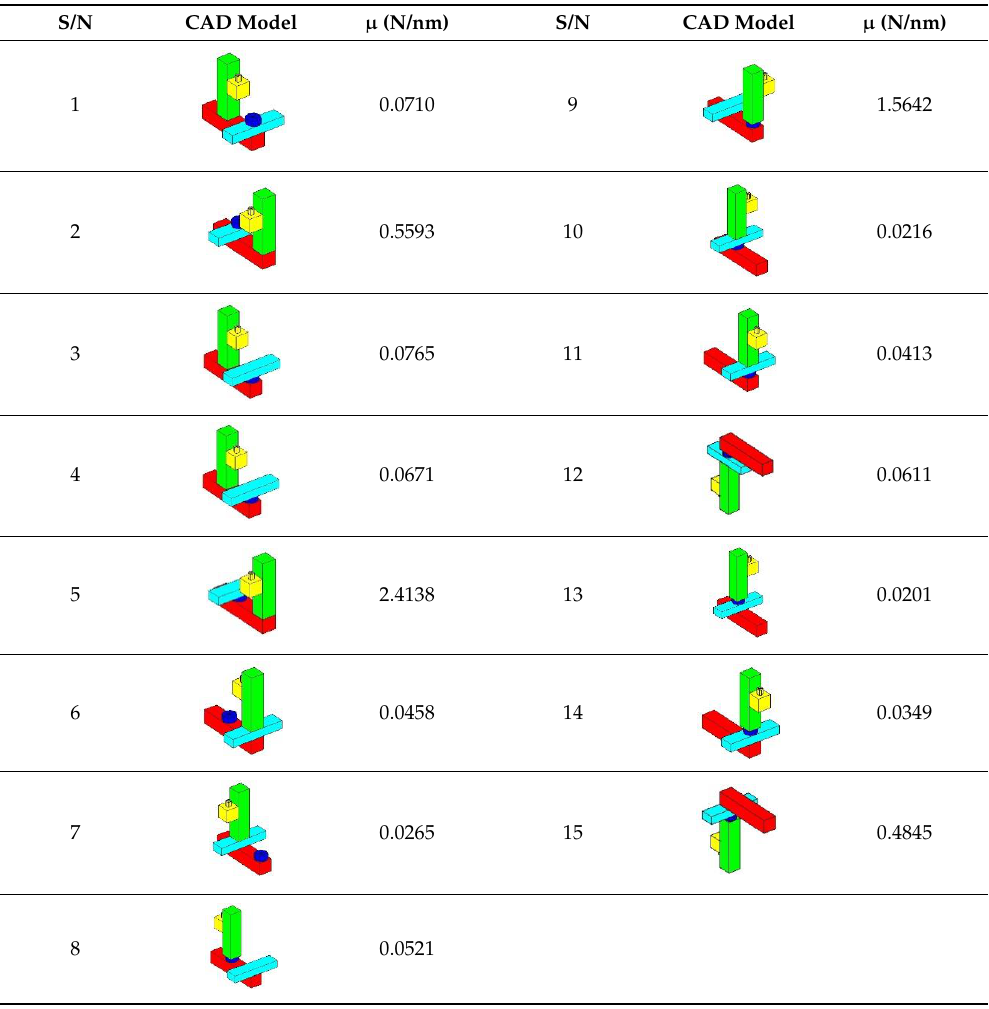
Table 8. Results of structural stiffness analysis.